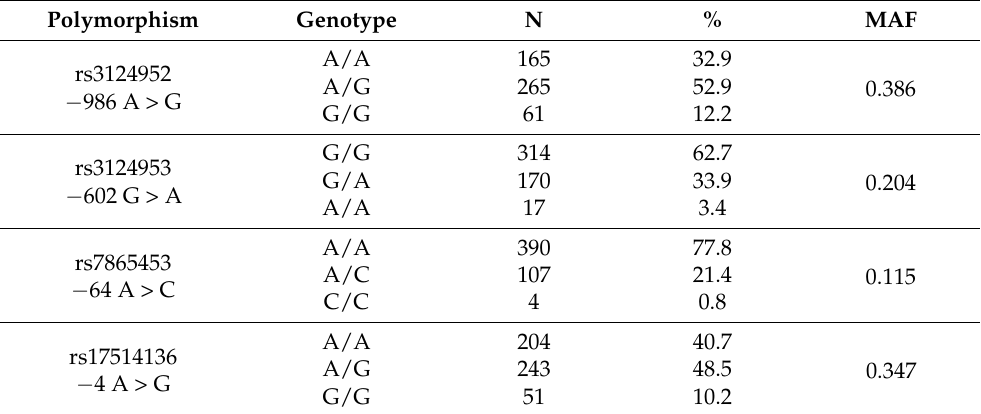
Table 1. Distribution of genotypes associated with FCN2 gene promoter polymorphisms in preterm newborns (n = 501).